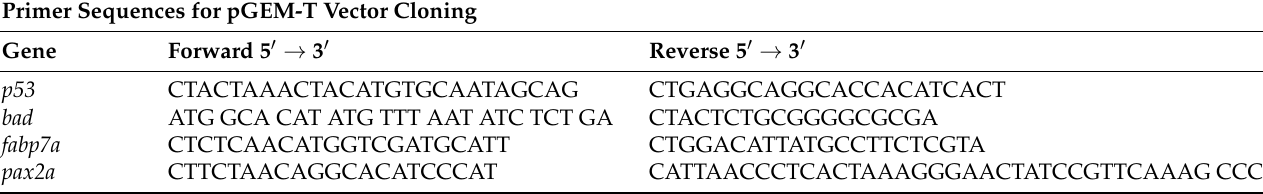
Table 1. Primer sequences used for gene cloning.